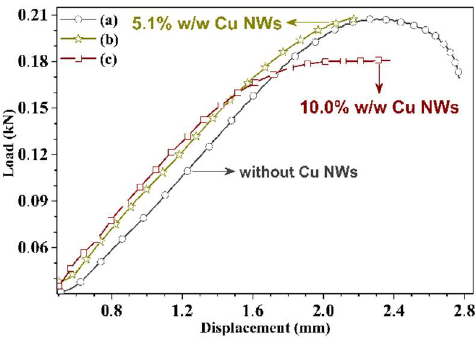
Figure 5. Representative load-displacement curves of specimens: (a) reference, resin without Cu NWs ( ◦ ), (b) with Cu NWs at 5.1% w / w ( ∗ ), and 10.0% w / w (□).